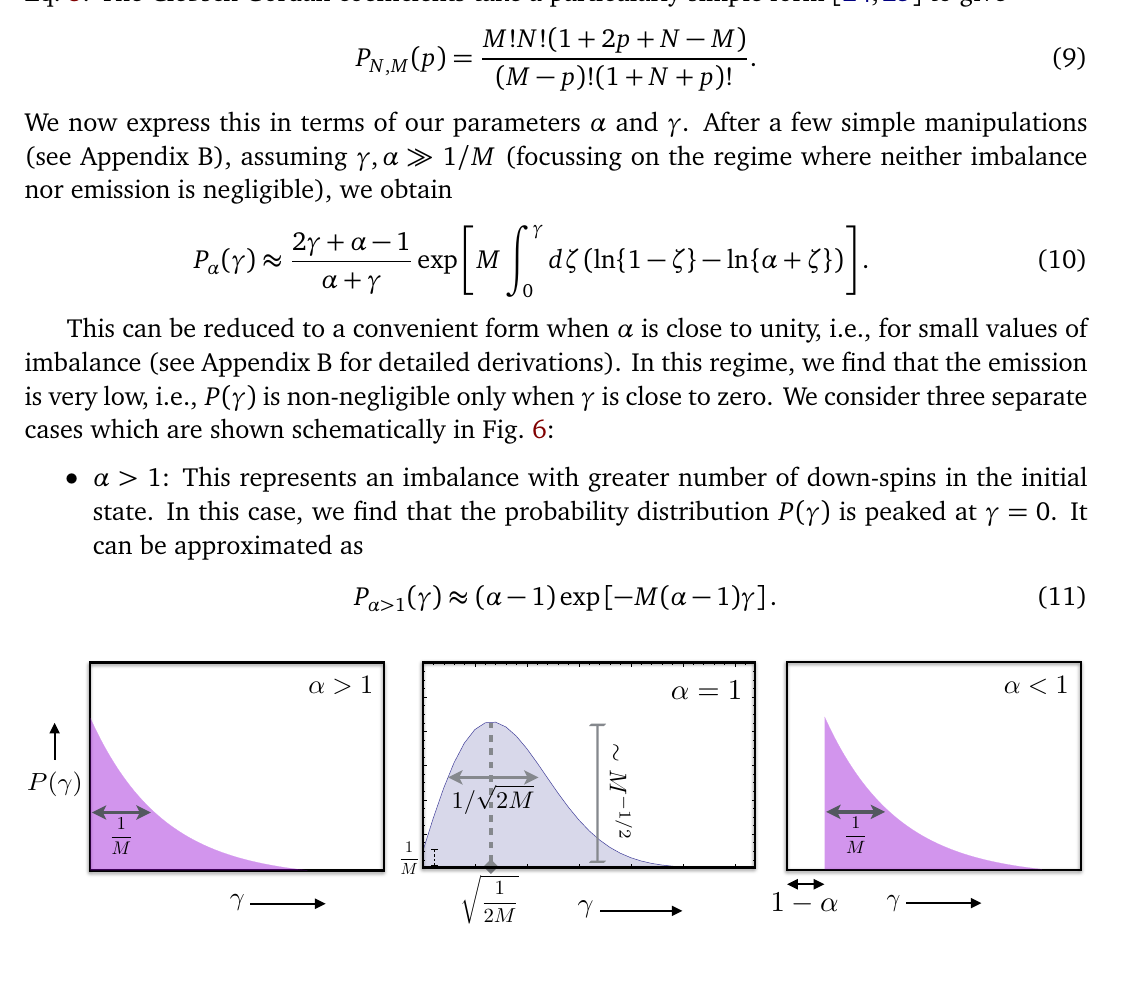
Figure 6: Probability distributions for photon emission in the thermodynamic limit. Left: Im- balanced case with more down-spins in the initial state ( N > M ). Centre: Balanced case with equal numbers of up- and down-spins initially ( M = N ). Right: Imbalanced case with more up-spins initially ( M > N